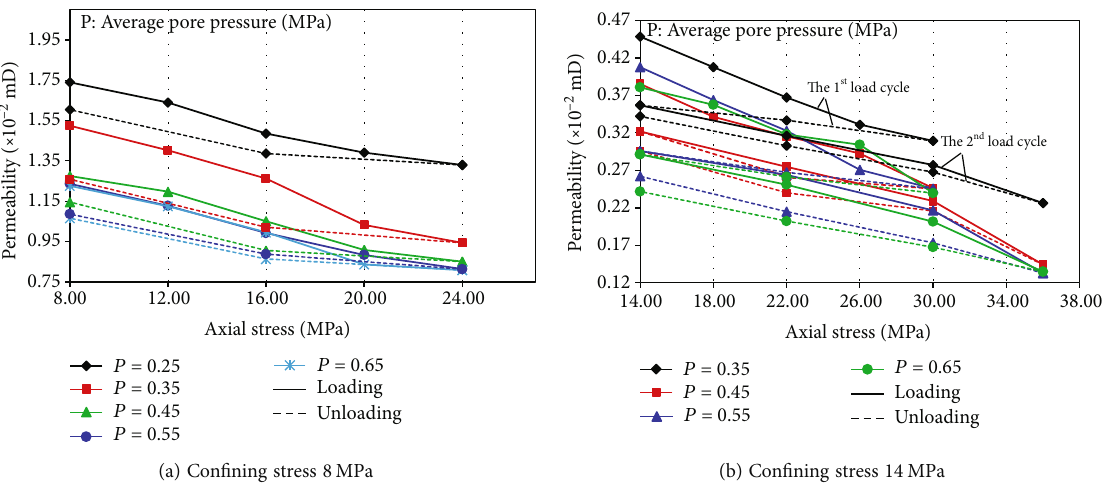
Figure 2: The permeability test results of coal sample C1 under hydrostatic